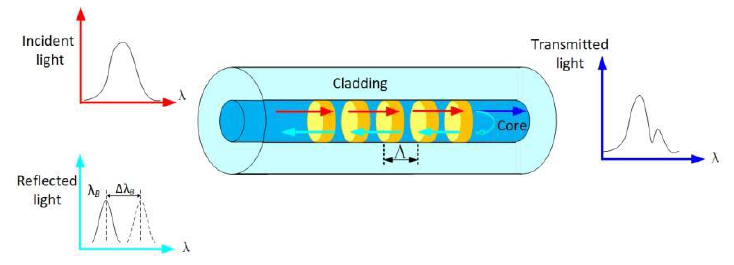
Figure 2. Principle of fiber Bragg grating sensing.